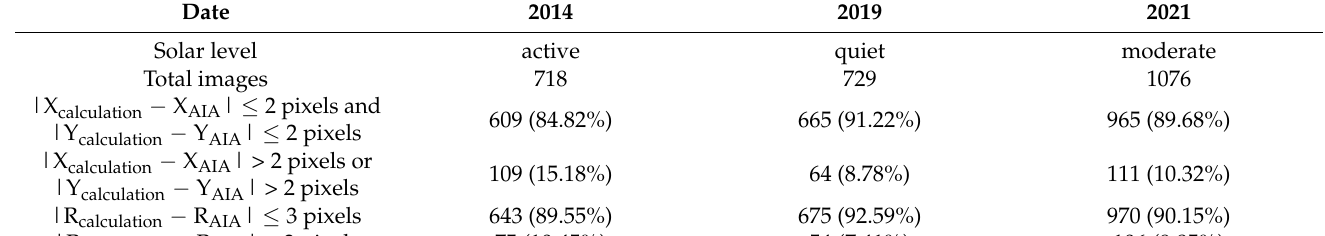
Table 1. Statistical comparison of the calculated solar centers and radii with the results of AIA.